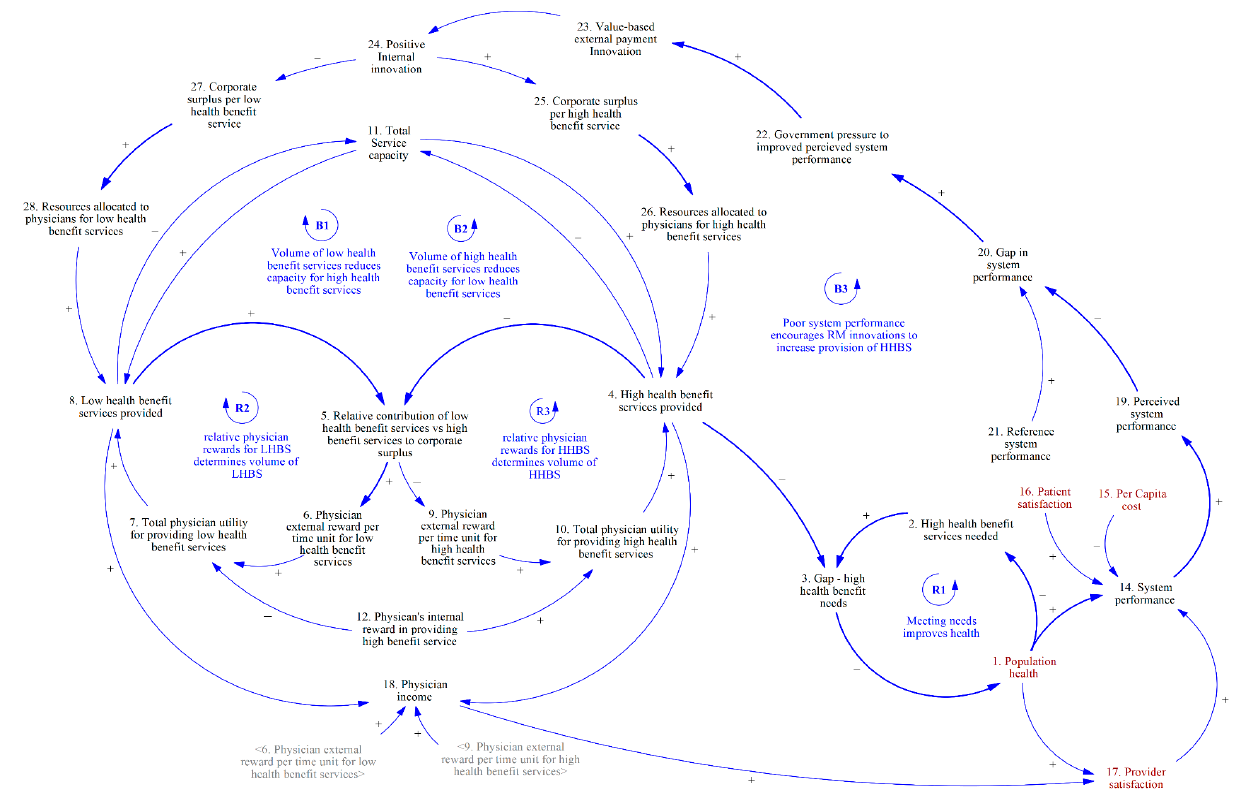
Figure 4. Government actions to increase the provision of HHBS to improve system performance.